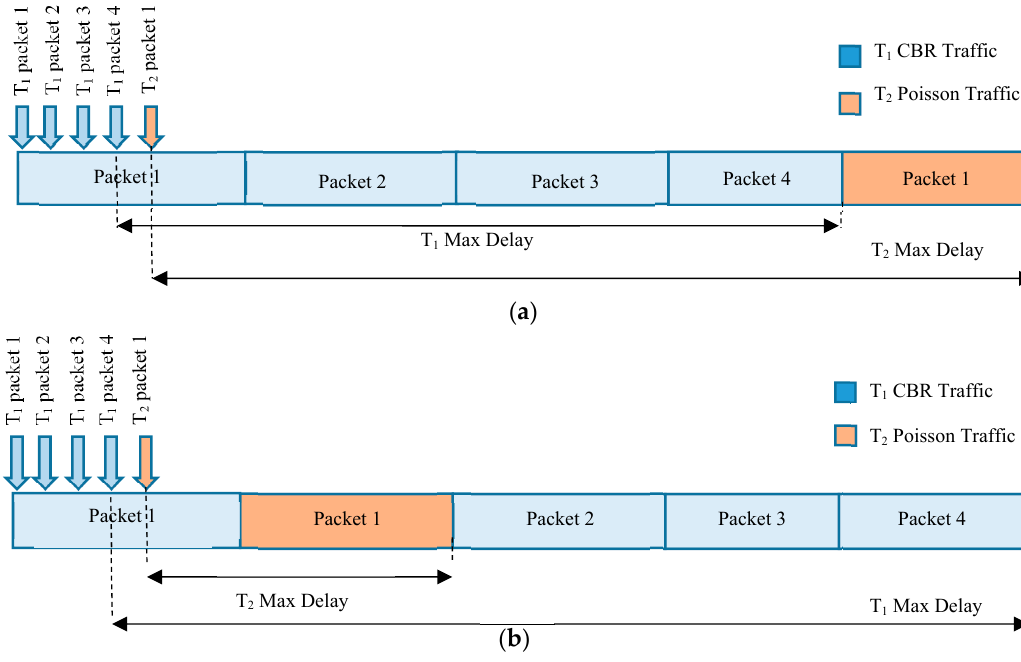
Figure 8. Delays for Low (CBR) and High (Poisson) Priority Traffic. ( a ) FCFS ( b ) Prioritization.